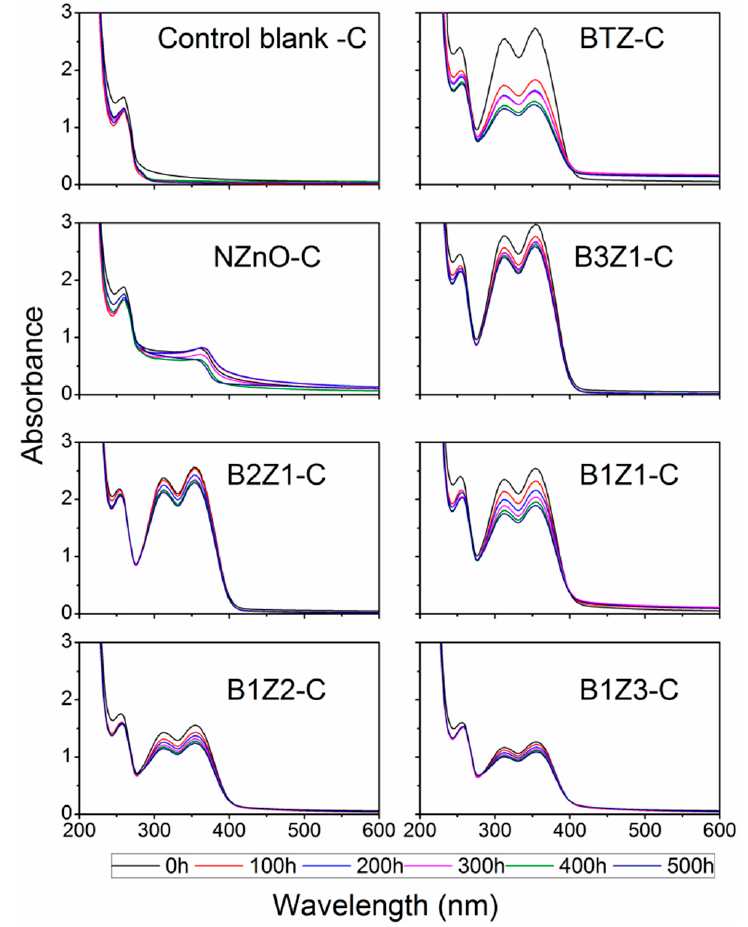
Figure 7. Aging-time-dependent UV-vis spectra of di ff erent film